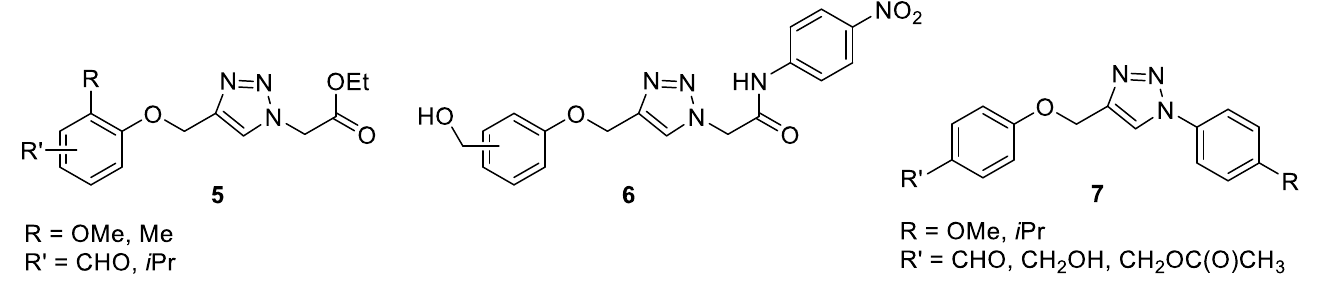
Figure 3. Examples of triazoles with antioxidant properties.